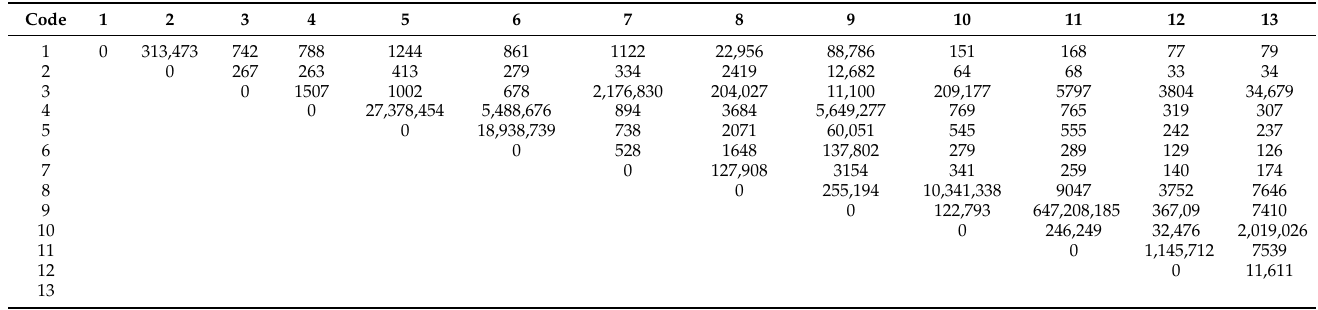
Table 4. Level of interaction of ecological